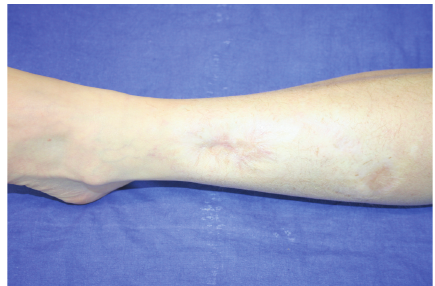
Figure 4: Result 12 months after the first grafting session, 6 months after the second